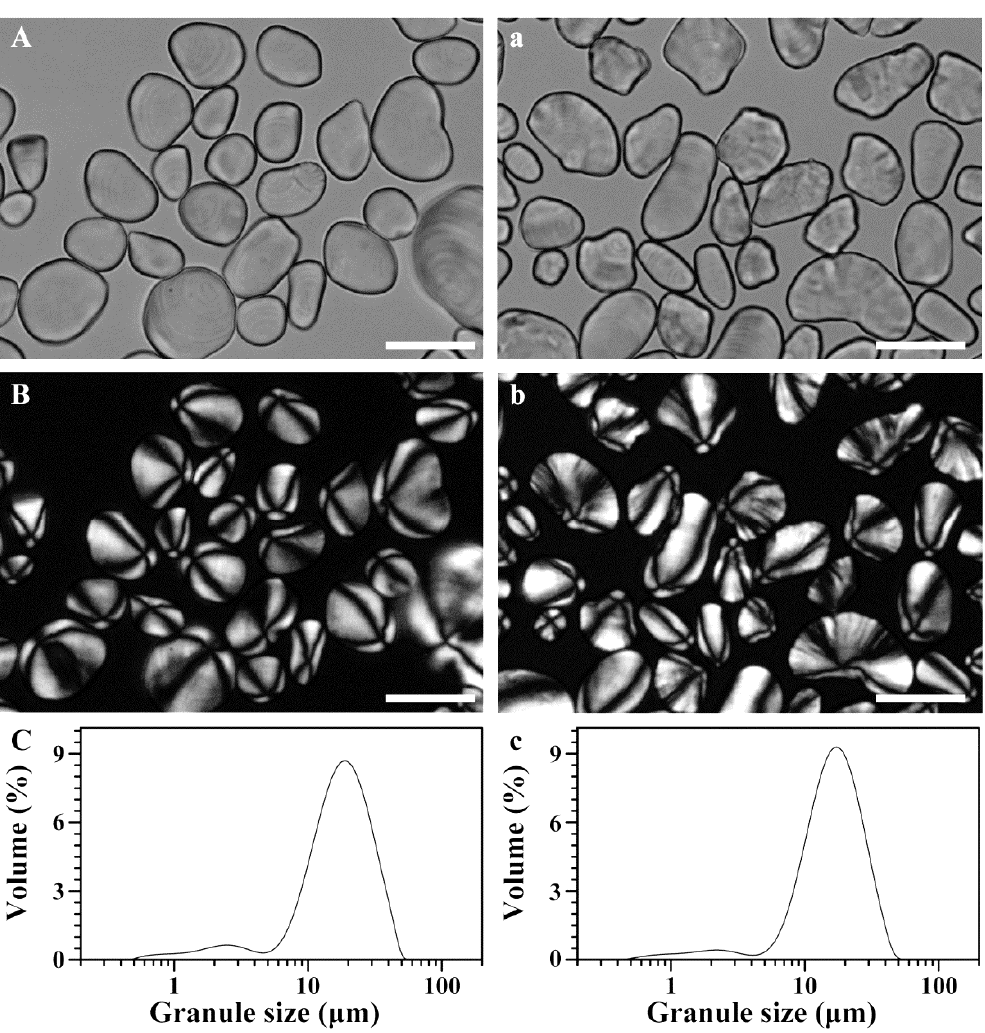
Figure 1. Morphology of starch granules under normal light ( A , a ) and polarized light ( B , b ), and their size distribution ( C , c ). ( A – C ), flesh starch; ( a – c ), peel starch. Scale bar = 20 μ m.